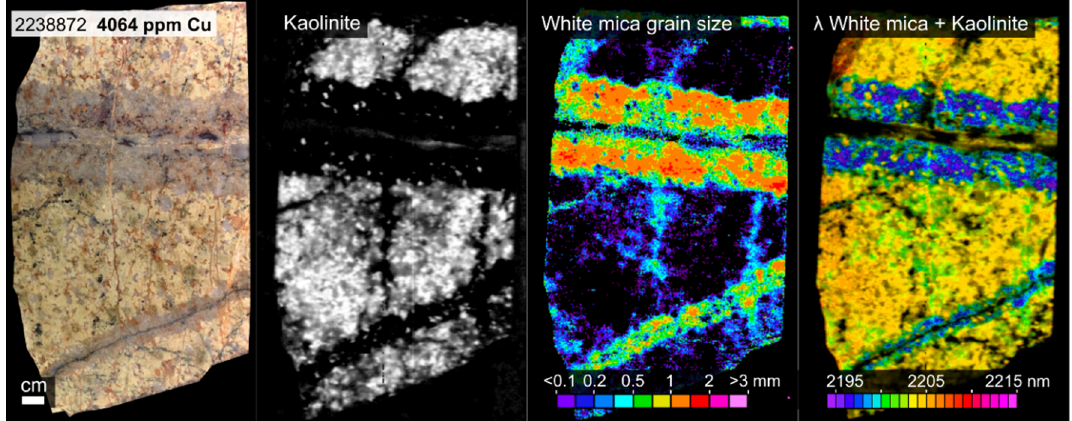
Figure A1. Sample 2238872, a mineralized sample (4064 ppm Cu) from the Skeena facies. The sample shows coarse grained, low-wavelength white mica veins in a kaolinite-rich matrix.